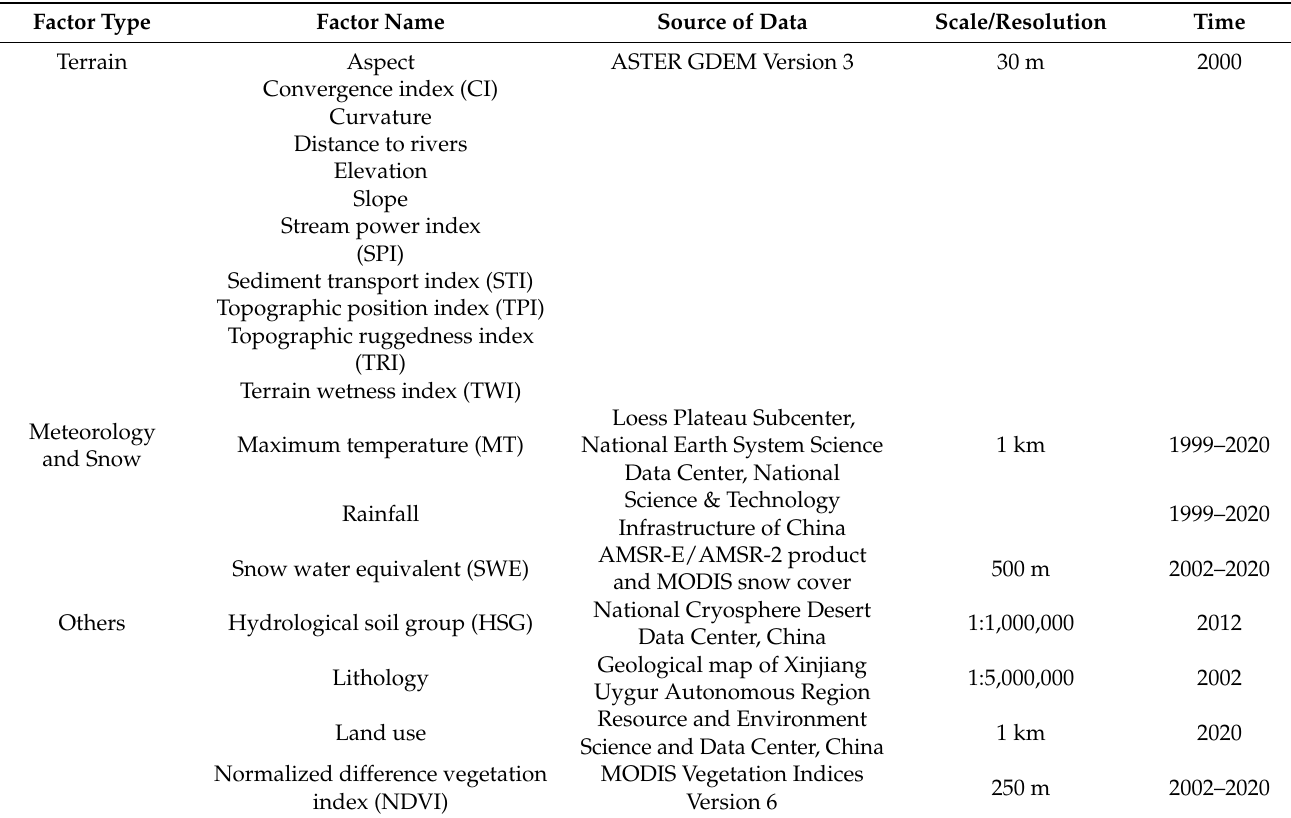
Table 1 contains a summary of these conditioning factors. The spatial distribution map of the data is categorized according to the natural breakpoint approach (Figure 2). The spatial resolution of all the conditioning factors was resampled to 30 m to maintain uniformity on a spatial scale. Long-term multitemporal data related to meteorological factors were processed by taking multi-year averages. A small portion of the few data that could not cover the historical flood duration started from the earliest available time. In addition, the data-standardization method was used to solve the problem of an inconsistent range of data values [64], which can prevent model parameters from failing to converge during model training. The data were input as the same size two-dimensional arrays. Flood events with different ranged sizes were divided by a fixed matrix to achieve incremental data, yielding 1105 positive sample datasets. An equal number of matrices was randomly generated as negative sample datasets in other areas which do not have snowmelt flooding as in the study area to meet the model’s training needs. Referring to the division basis of DL-related studies [48], while ensuring that the model is adequately trained, the whole dataset is divided into training and validation sets in the ratio of 7:3. Table 1. Flood conditioning